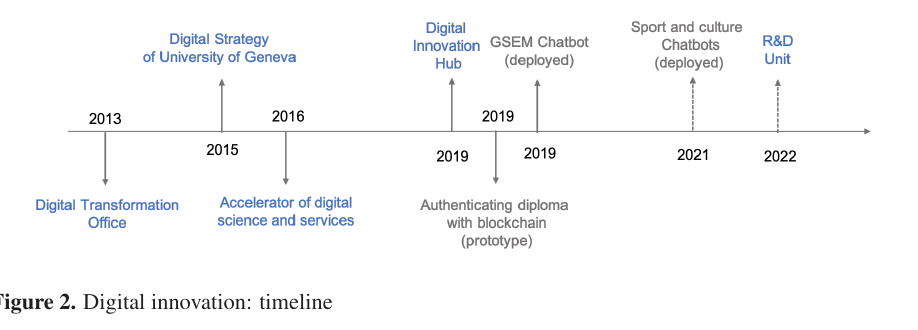
Figure 2. Digital innovation: timeline